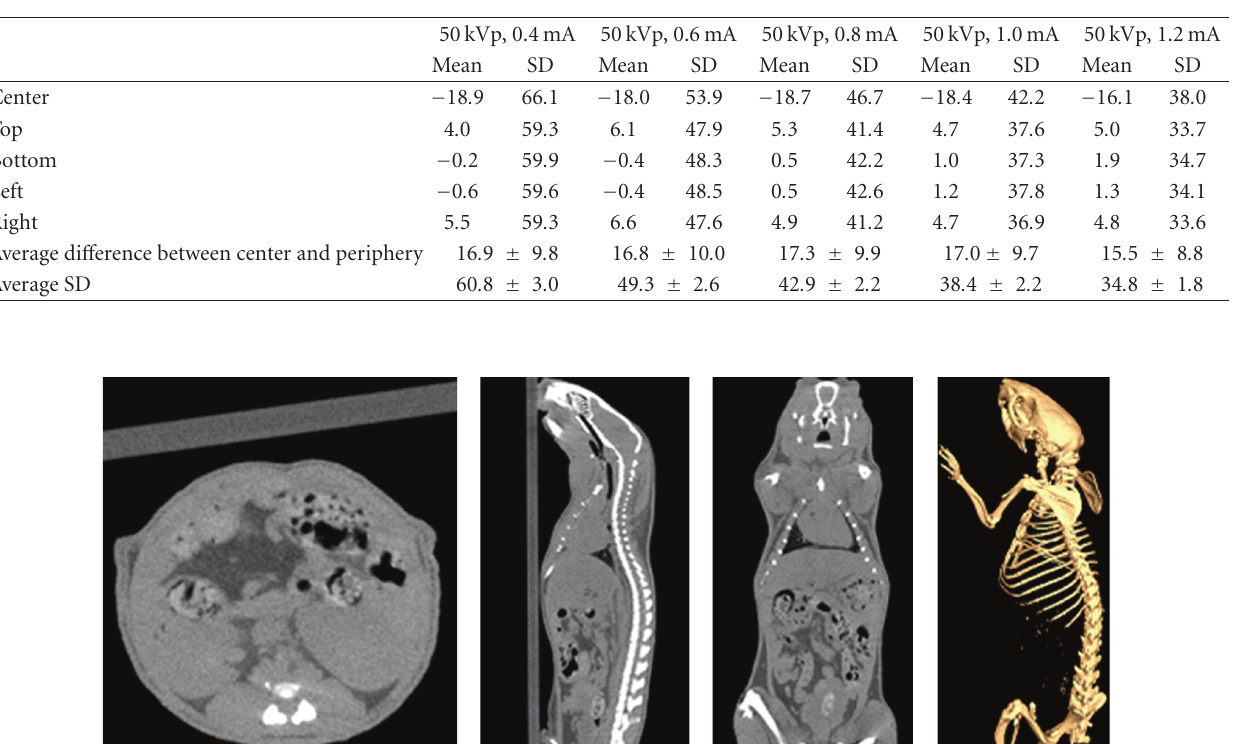
micro-CT system. The e ff ects of the magnification ratio and filter kernel are illuminated in the figure clearly. The spatial resolution in the periphery of the phantom is a little lower than that near the center, but not obviously. At a lower magnification ratio ( M = 1 . 3), the spatial resolution is about 9 lp/mm at 10% of the MTF curve with ramp function kernel and 6.5 lp/mm with cosine window kernel, while it reaches about 14.5 lp/mm with ramp function kernel and 10.5 lp/mm with cosine window kernel at a higher magnification ratio ( M = 2 . 36).